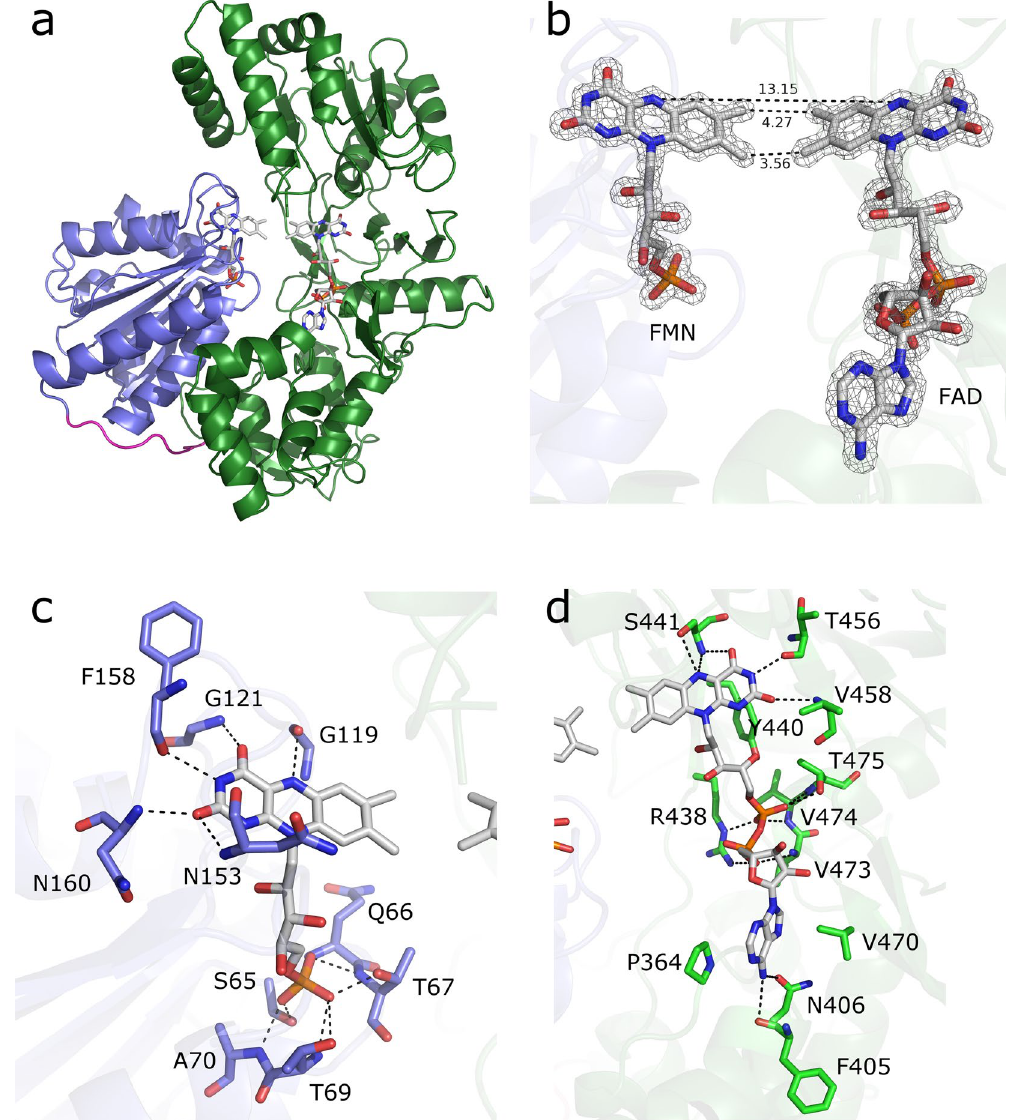
Figure 3. Crystal structure of Ct CPR. ( a ) Ribbon diagram showing the overall fold of Ct CPR, with cofactors modelled as ball and sticks. FMN-binding domain (blue), hinge loop (magenta) and FAD- and NADPH- binding domain (green). ( b ) FMN and FAD cofactors of Ct CPR with 2Fo-Fc electron density maps contoured at 2 σ . Interatomic distances depicted as dashed lines with distances in Å ( c ) FMN-binding and ( d ) FAD-binding in the active site of Ct